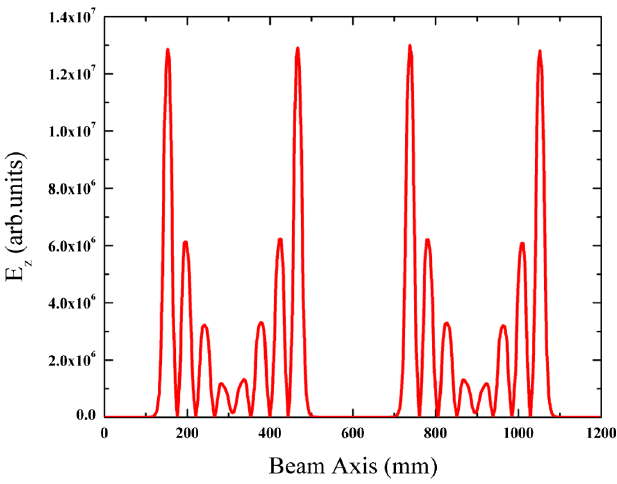
FIG. 30. Layout of the existing GSI facility and the future FAIR accelerator